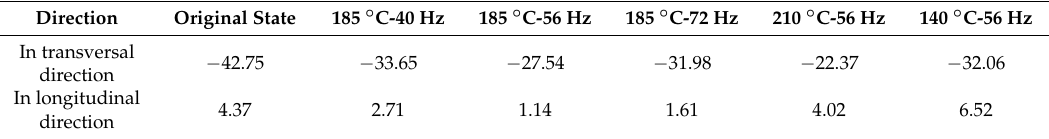
Table 6. Mean values of the average stress at four measuring points, before and after TVSR at different parameters. Unit: